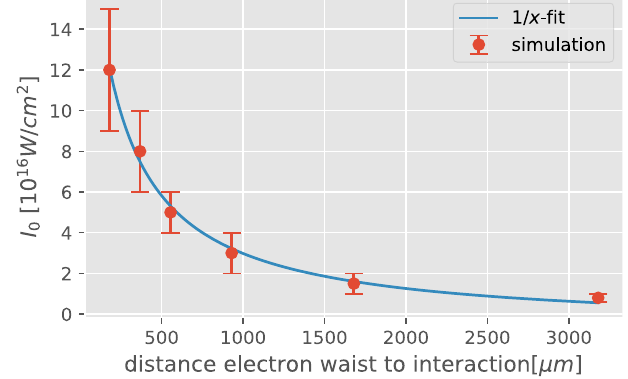
FIG. 4. Optimum peak intensity of a single laser used, to get strongest modulation signal in momentum space of the electron beam ( γ e ¼ 100 , σ x ¼ 150 nm, σ x 0 ¼ 2 mrad, σ z ¼ 2 μ m) for various distances between electron beam being at waist and laser- electron interaction. The vertical bars indicate the intensity range over which the change in maximum modulation depth is less than 5%.